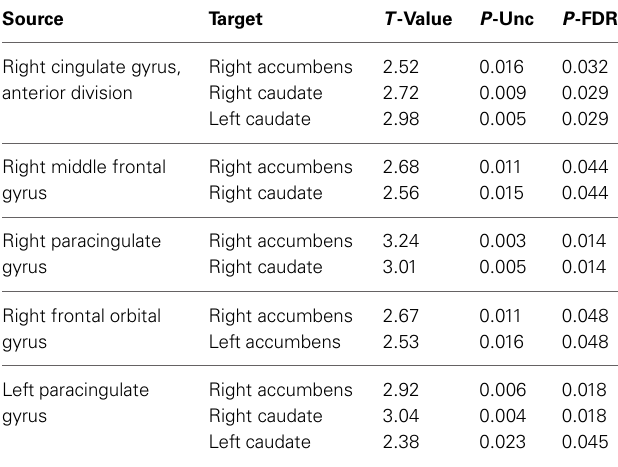
Table 2 | T-scores and p -values for regions showing significantly increased connectivity in the ASD group, controlling for age, IQ and frame-wise